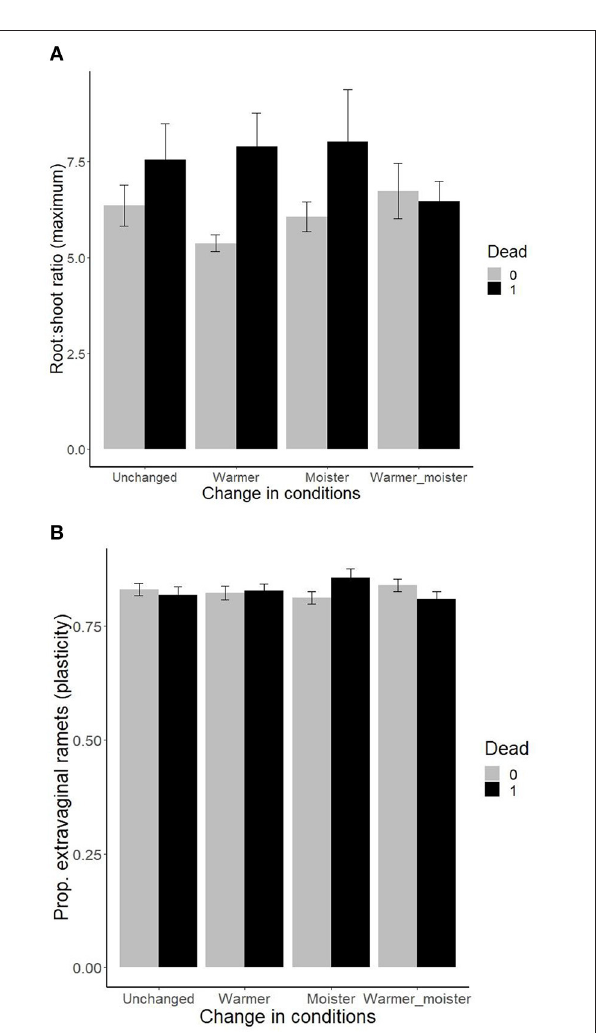
FIGURE 3 | Effects of plant traits [ (A) plasticity in root:shoot ratio and (B) plasticity in production of extravaginal ramets] measured within previous growth chamber experiments (Münzbergová et al., 2017; Kosová et al., 2020) on survival of ramets within the field transplant experiment under different levels of moisture and temperature. The values represent mean ±